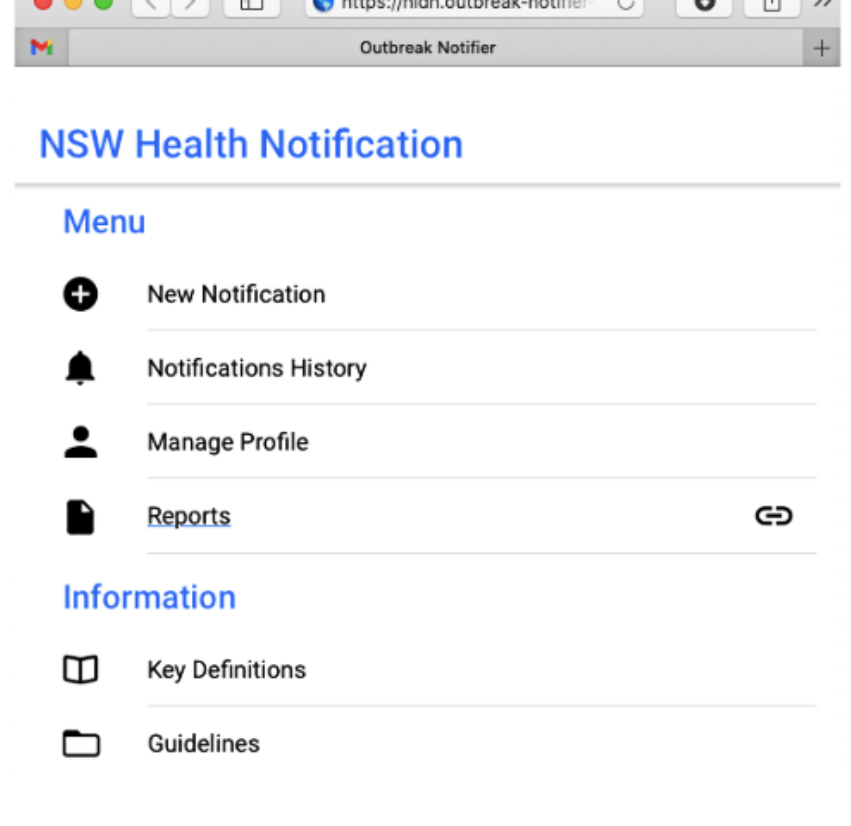
Figure 5. A web version of our mobile app with a consistent user interface. Web technologies such as HTML 5, Cascading Style Sheet 3, and JavaScript were used.